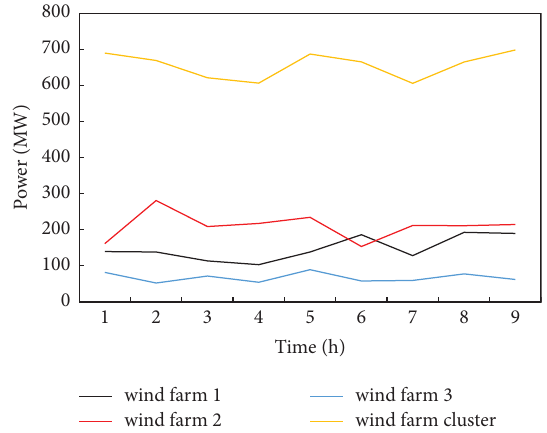
Figure 5: Output fuctuations of wind farms.